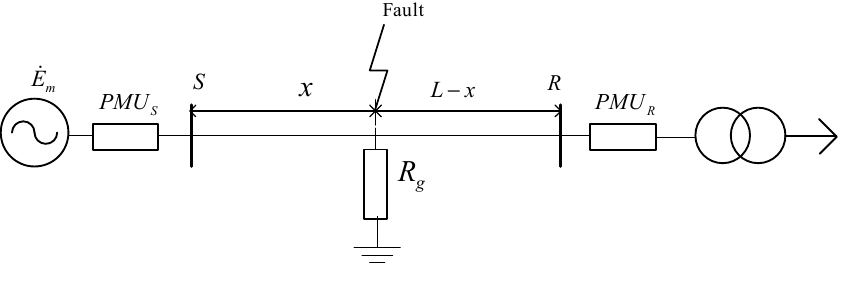
Figure 4. Equivalent network diagram.